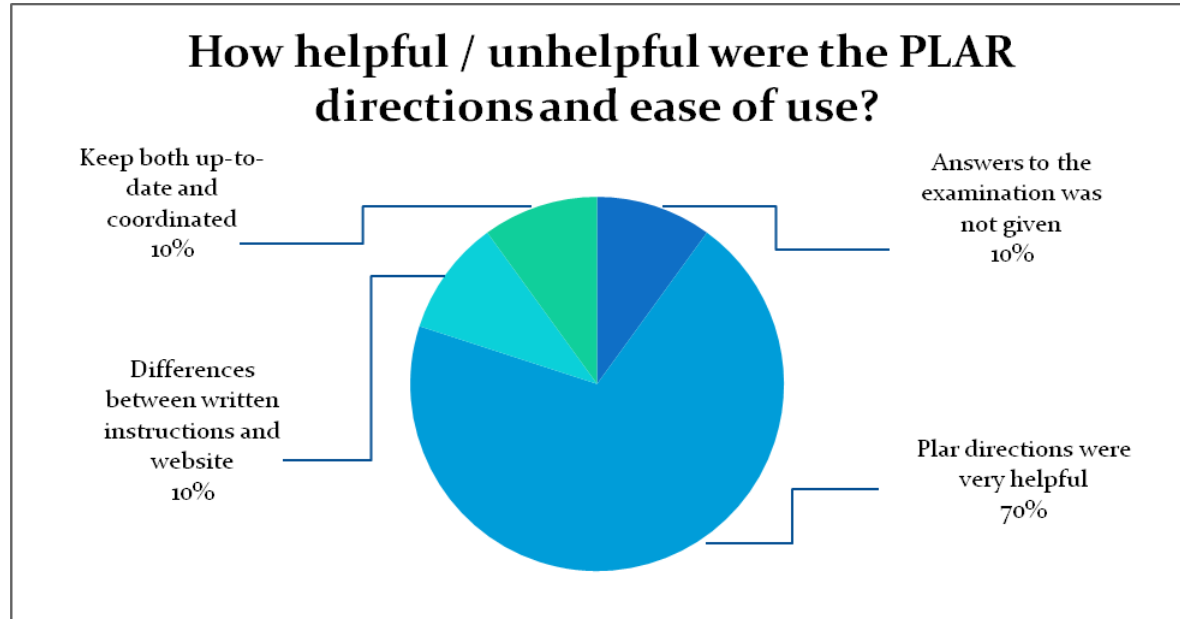
Figure 4 . Ease of use of PLAR online